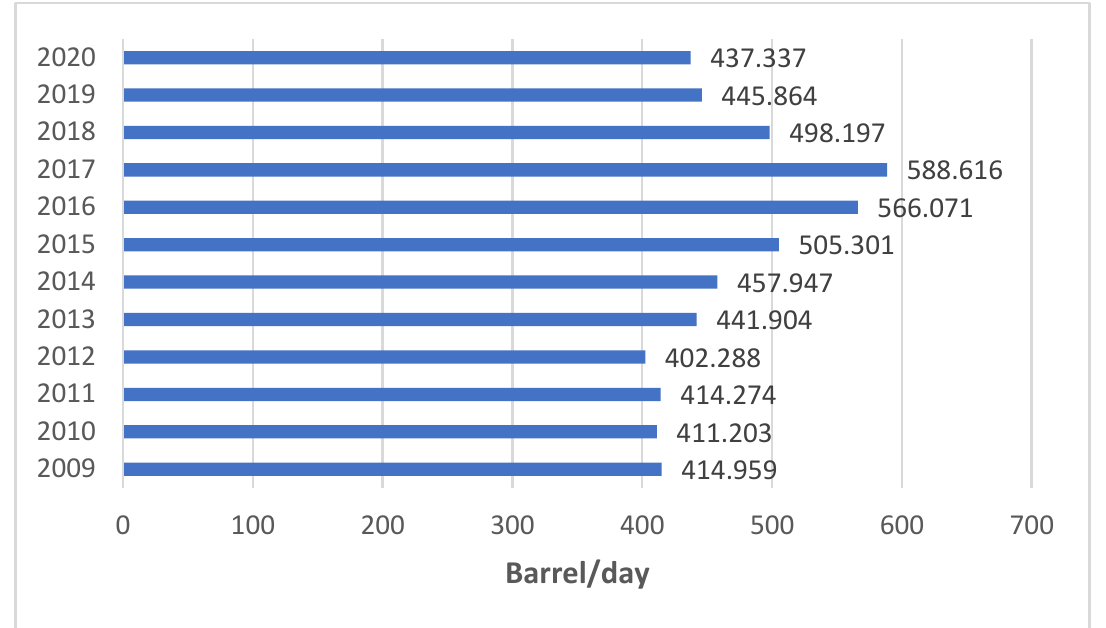
Figure 1. Oil consumption in Pakistan [4].